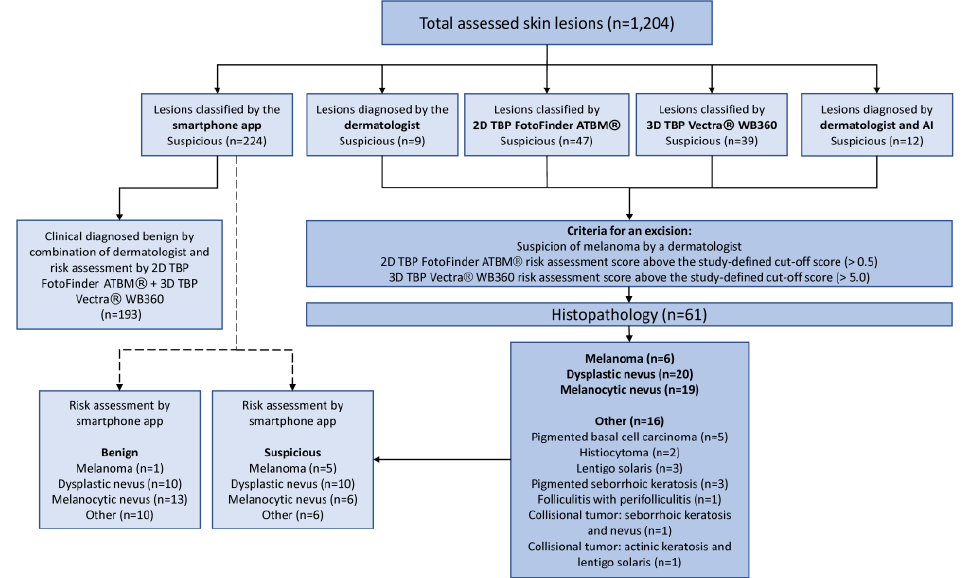
Figure 1. Flow chart of all included pigmented skin lesions and their histopathological outcome. AI = artificial intelligence; TBP = total body photography.